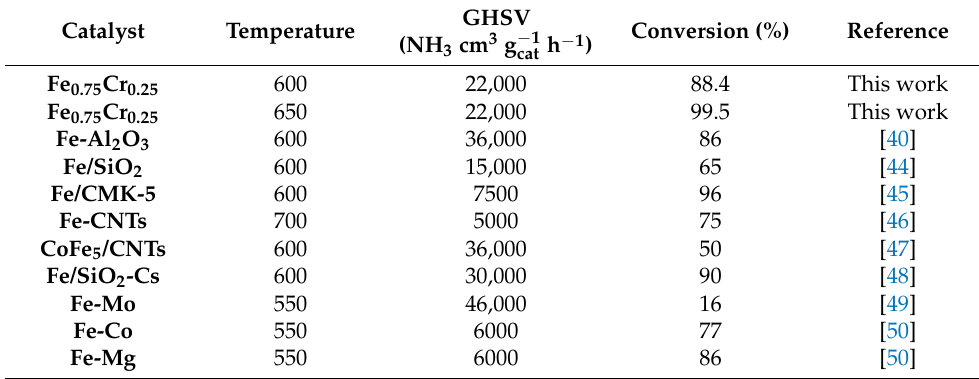
Figure 3. ( a ) NH 3 conversion as a function of reaction temperature during NH 3 decomposition reac- tion with the FeCrO x catalysts, and the dotted line is the data of the thermodynamic equilibrium [43]. ( b ) Arrhenius plots of NH 3 conversion over FeCrO x catalysts, and ( c ) stability tests of Fe and Fe 0.75 Cr 0.25 catalysts. All catalysts’ performances were tested with a gas hourly space velocity (GHSV) of 22,000 cm3 g −1 h −1 . cat Table 2. Comparison of ammonia conversion with different Fe-based catalysts.